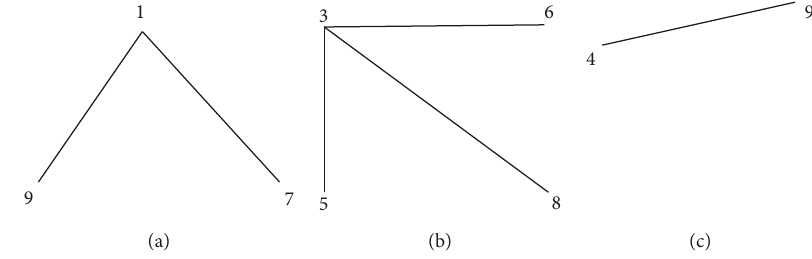
Figure 11: Example for the CHIP edge formulation (with t